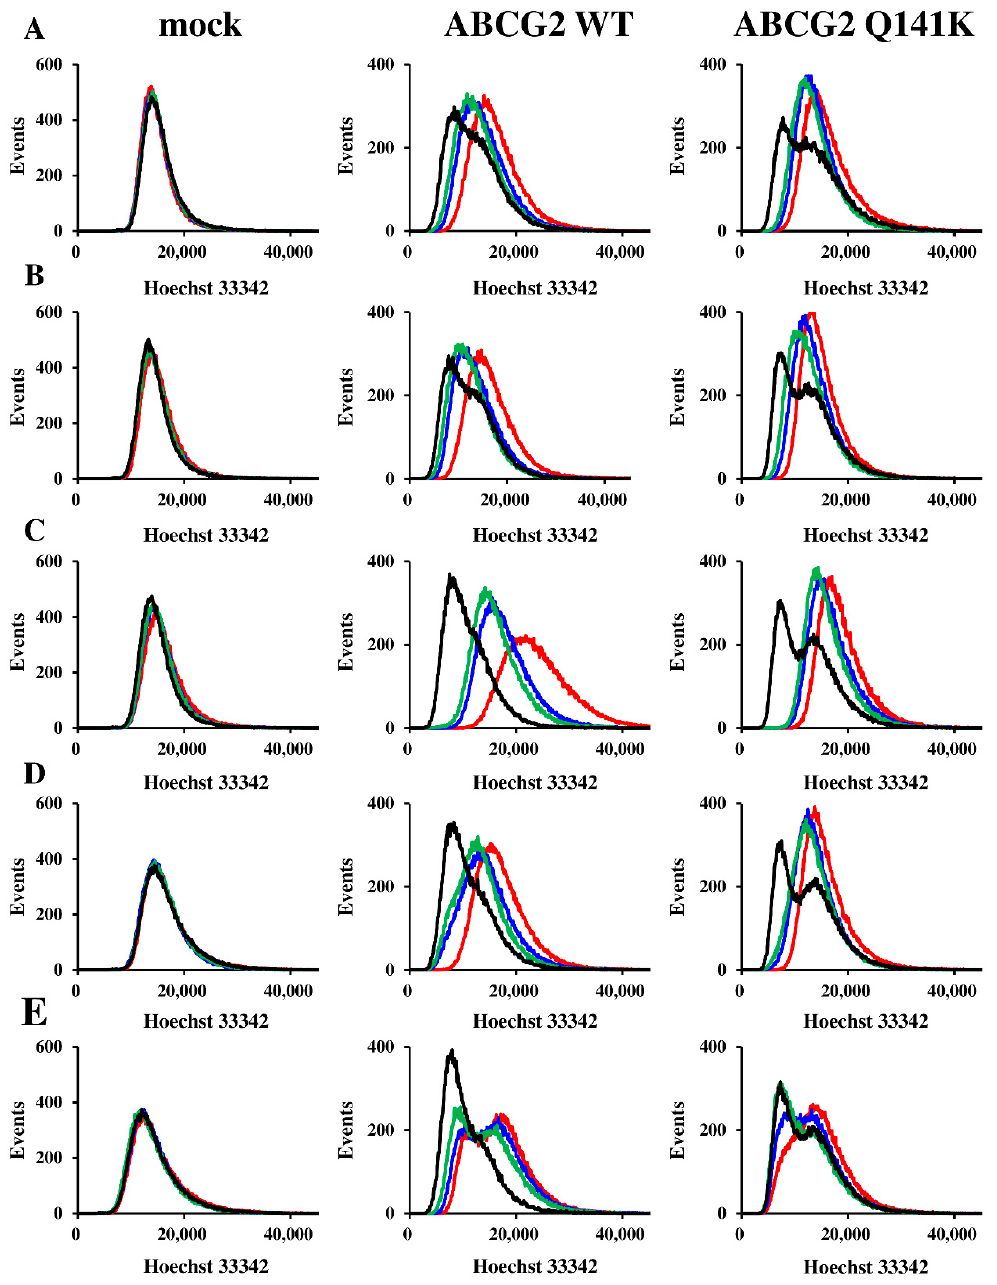
Figure 5. Effects of the EGFR TKIs on intracellular accumulation of Hoechst 33342. Hoechst 33342 alone or Hoechst 33342 combined with ( A ) gefitinib, ( B ) erlotinib, ( C ) lapatinib, ( D ) afatinib, or ( E ) Novobiocin was added to Flp-In-293 / mock cells, Flp-In-293 / ABCG2 WT cells, and Flp-In-293 / ABCG2 Q141K cells. The black line indicates cells incubated with Hoechst 33342 alone. ( A – D ) The red, blue, and green lines indicate incubation of cells with Hoechst 33342 combined with EGFR TKIs at 5 µ M, 1 µ M, and 0.5 µ M, respectively. ( E ) The red, blue, and green lines indicate 10 µ M, 5 µ M, and 1 µ M novobiocin, respectively. Each experiment was repeated three times.